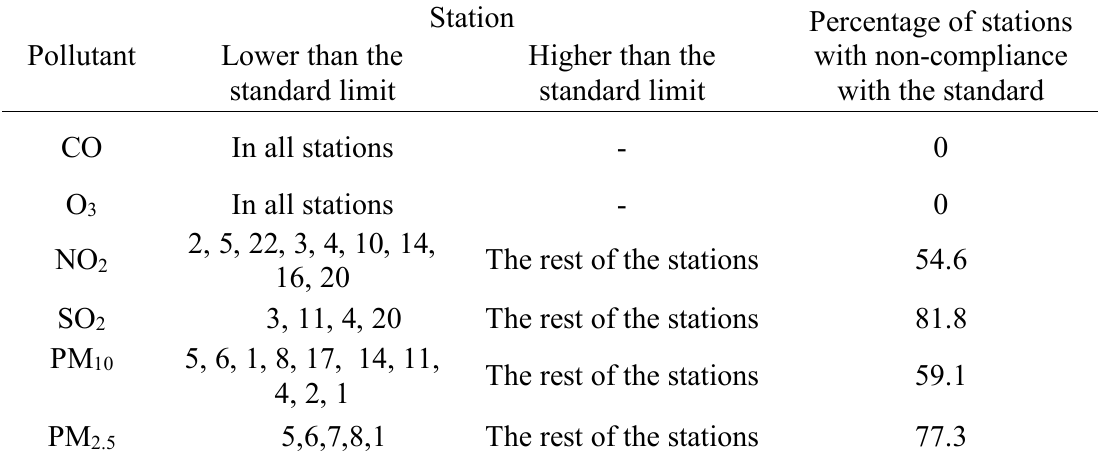
Table 3. The analysis of air pollutants on January, 2018